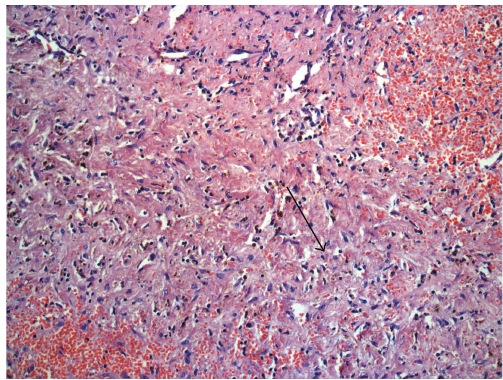
Figure 1: Ovarian stroma H&E × 100.